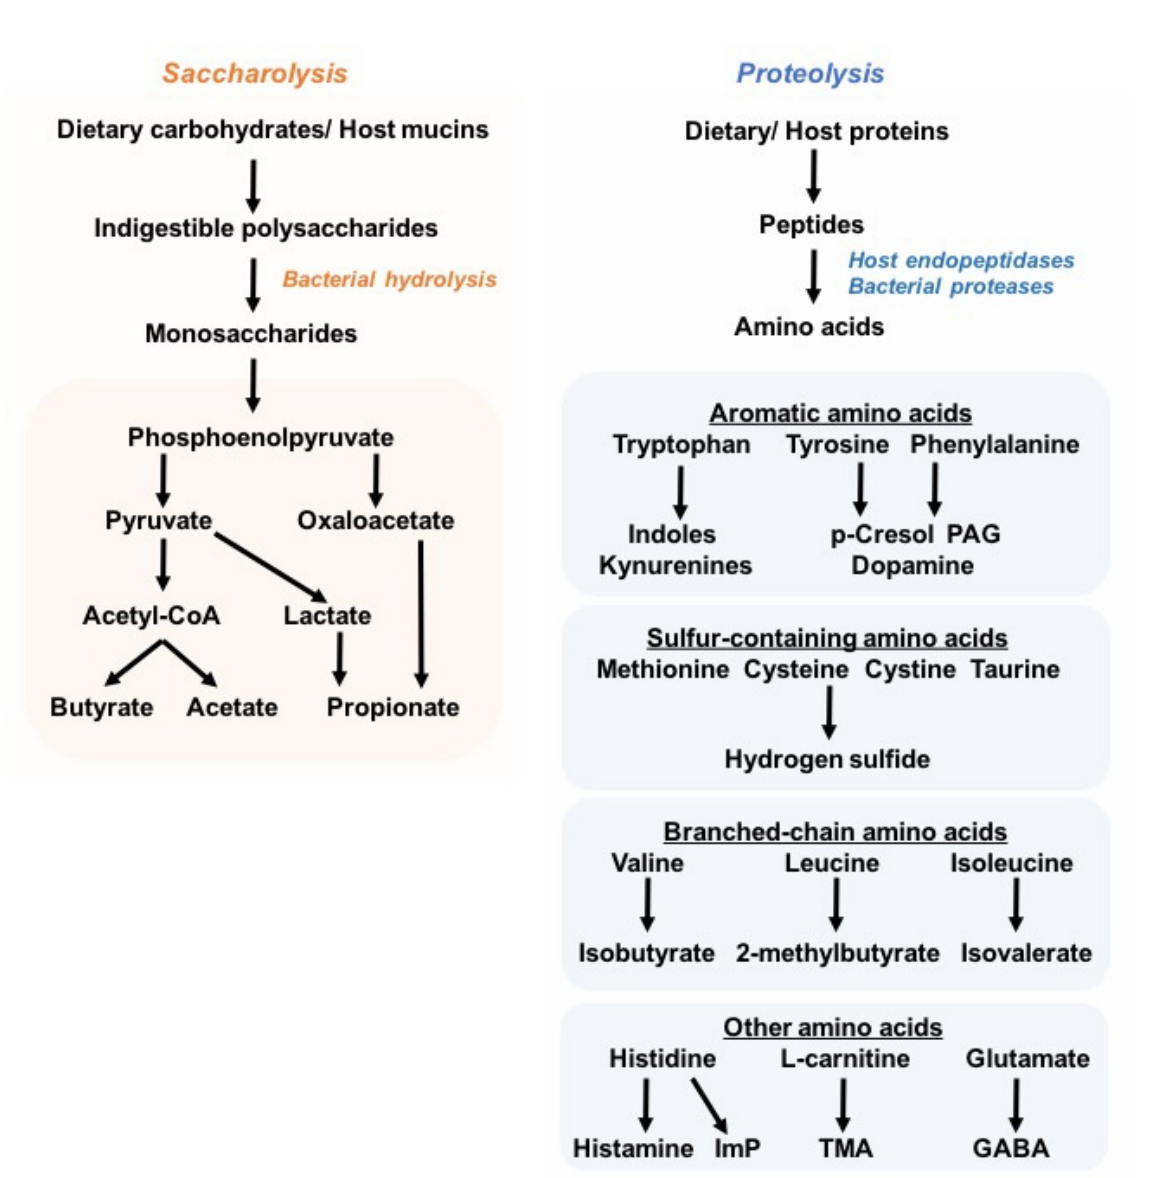
Figure 1. Myriad commensal bacteria can metabolize dietary and host-derived carbohydrates or proteins generating short-chain fatty acids (e.g., butyrate, acetate, propionate, and lactate) and diverse amino acids’ catabolites (through diverse bacterial pathways degrading aromatic, sulfur-containing, branched-chain, and other amino acids), respectively.